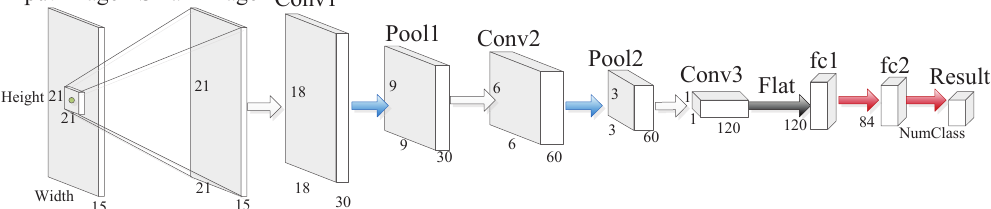
Figure 4. The architecture of CNN used for PolSAR image classification, where we use a 21 × 21 neighborhood of each pixel as the small image, and the small image is the input of the CNN model. In addition, Conv represents the convolutional layer, Pool represents the max pooling layer, flat represents the flat operation, fc represents the full connected layer, and Result represents the classification